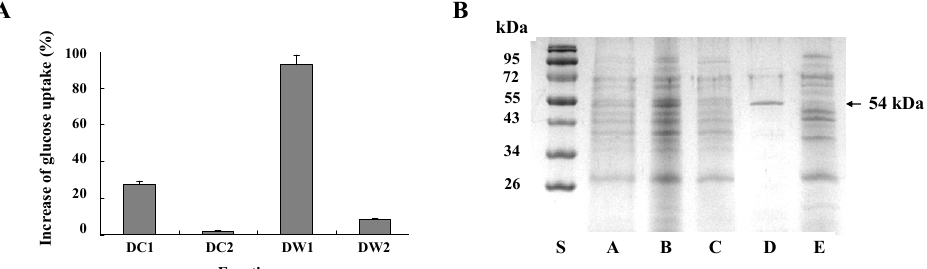
Figure 6. Effect of protein fractions harvested from S. pastorianus extract on glucose uptake of 3T3-L1 cells. ( A ) Increased glucose uptake percentage in 3T3-L1 cells treated with various fractions. ( B ) SDS-PAGE of S. pastorianus extract and fractions isolated from the DEAE cellulose column followed by DOWEX 50WX8-200 column chromatographs of S. pastorianus extract. S: standard markers; A: S. pastorianus extract; B: DC1; C: DC2; D: DW1; E: DW2. Table 3. The amino acid sequence of 54 kDa protein from S. pastorianus extract.